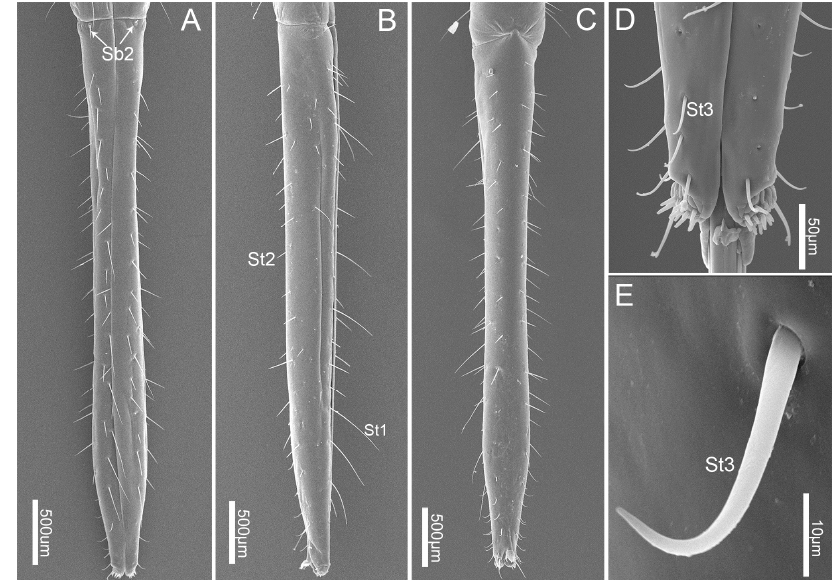
Figure 6. SEM images of the fourth labial segment. ( A ) Dorsal view; ( B ) lateral view; ( C ) ventral view; ( D ) apex of fourth labial segment from dorsal view; and ( E ) enlarged view of sensillum trichodeum III (St 3). St 1, sensilla trichodea I; St 2, sensilla trichodea II; St 3, sensilla trichodea III; St 4, sensilla trichodea IV; and Sb2, sensilla basiconica II.